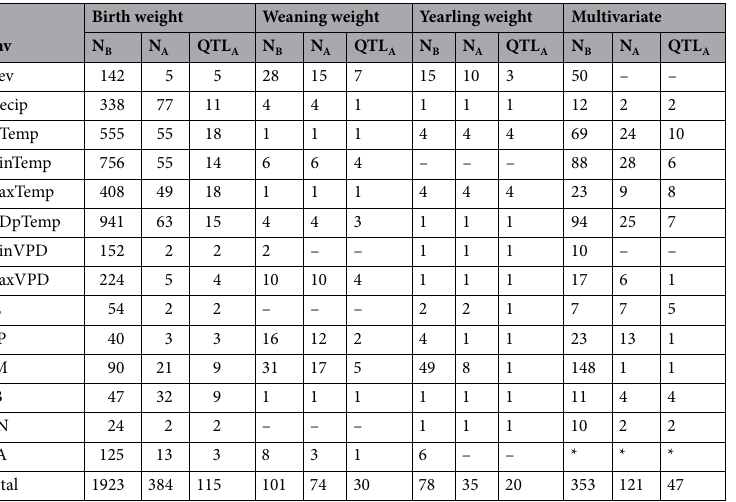
Table 1. Results of the G × E GWAA before and after adjustment for genomic control using continuous environmental variables or United Stated ecoregions as environmental factors in univariate and multivariate analysis for birth weight, weaning weight, and yearling weight. Env environmental variables, N B number of significant SNPs prior to genomic control adjustment, N A number of significant SNPs after genomic control adjustment, QTL A number of significant G × E QTL based on haplotype blocks of the significant G × E SNP after adjustment for genomic control, Elev elevation, Precip precipitation, MTemp mean temperature, MinTemp minimum temperature, MaxTemp maximum temperature, MDpTemp mean dew point temperature, MinVPD minimum vapor pressure deficit, MaxVPD maximum vapor pressure deficit, SE Southeast, HP High Plains, FM Forested Mountains, FB Fescue Belt, UN Upper Midwest and Northeast, DA Desert and Arid Prairie. The complete description of the G × E SNPs can be found in the Additional files 3 and 4. *Multivariate G × E GWAA was not performed for DA due to small sample